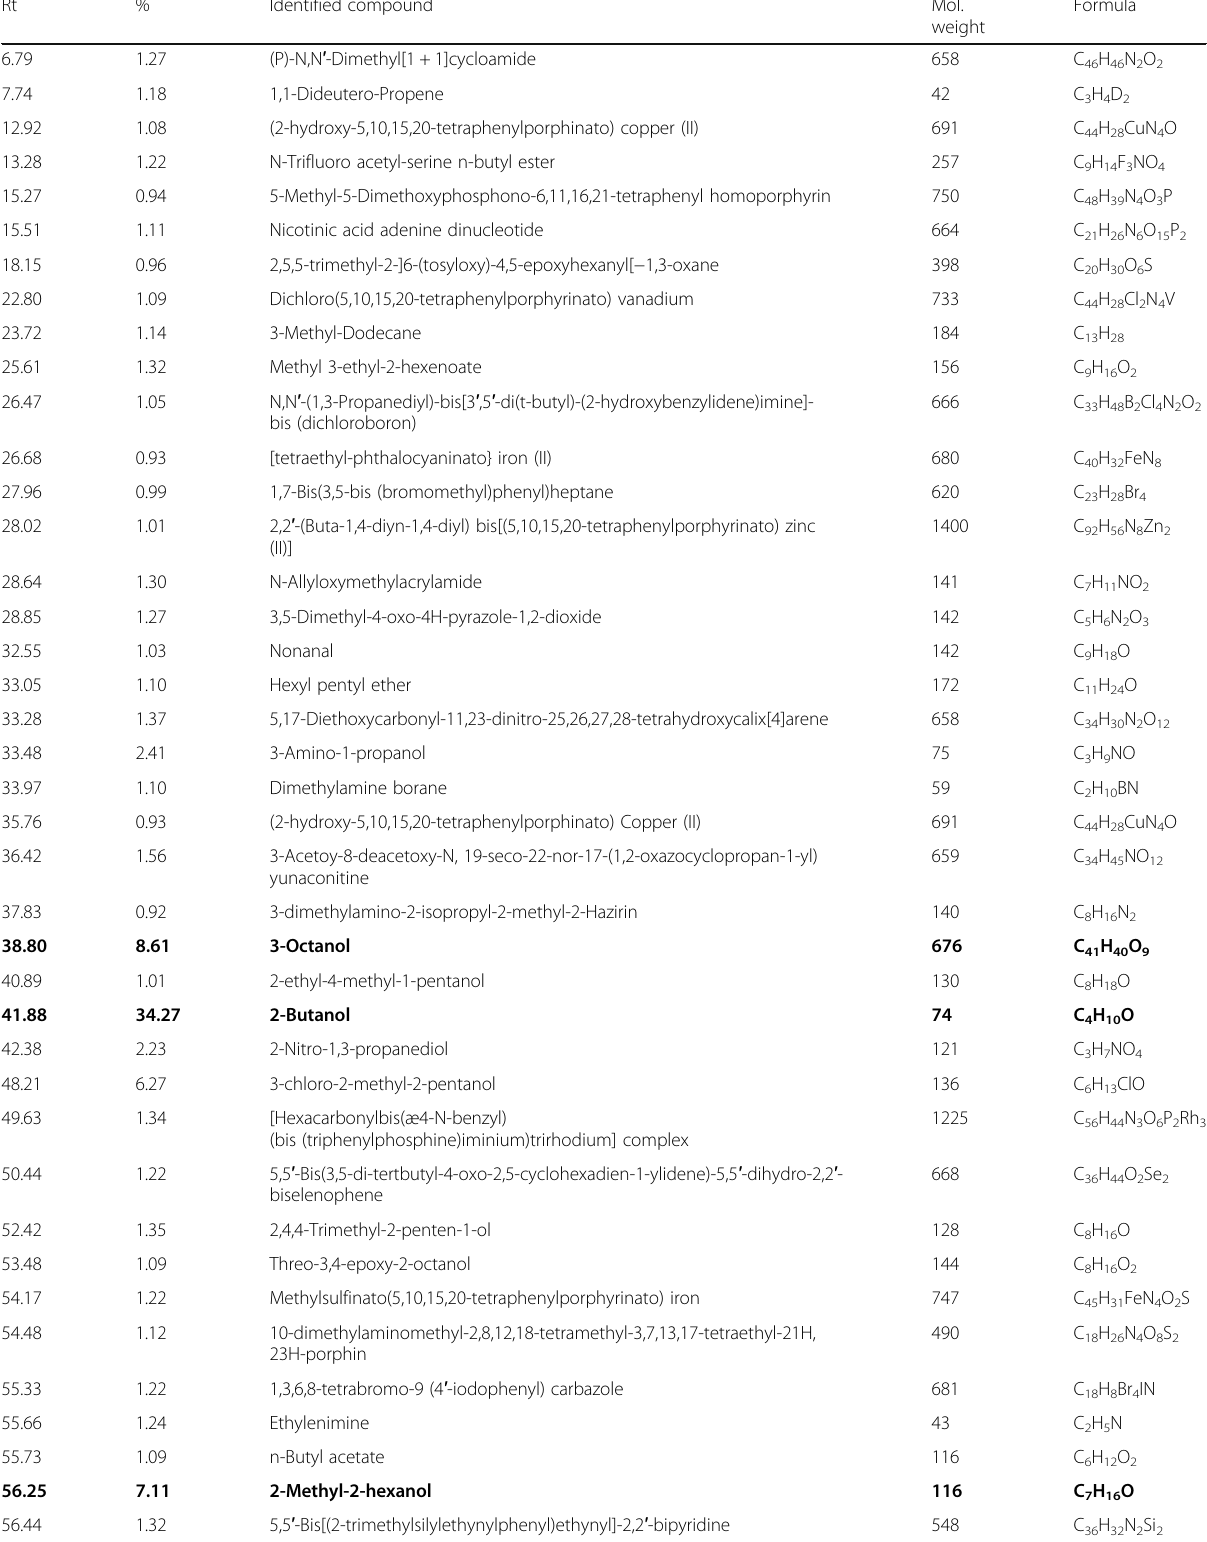
Table 3 GC/MS analysis of the M. oleifera leaves extract before incorporating Ag-NPs Rt % Mol.